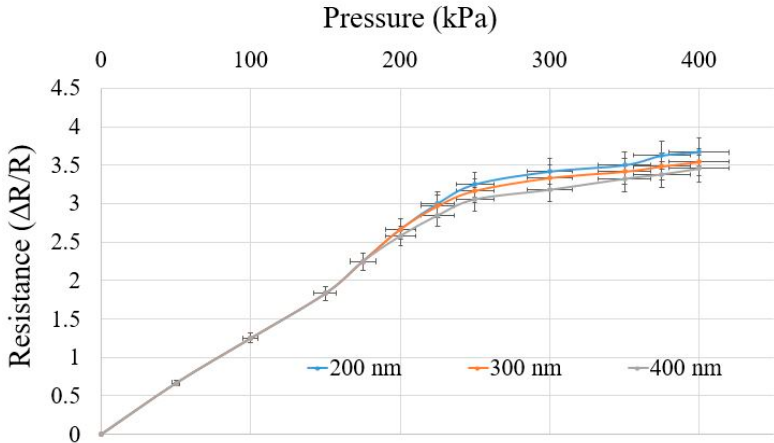
Figure 7. The response of the sensors for the change in pressure ranging between 0 and 400 kPa. The experiments were done on three types of prototypes differing in the thickness of the gold layer for 200 nm, 300 nm and 400 nm.